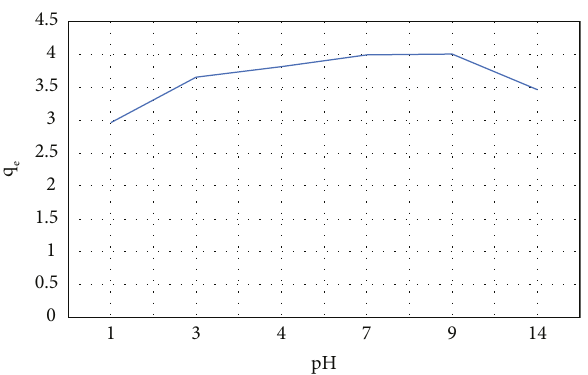
Figure 15: Effect of pH on adsorption of dieldrin onto nanocomposite.